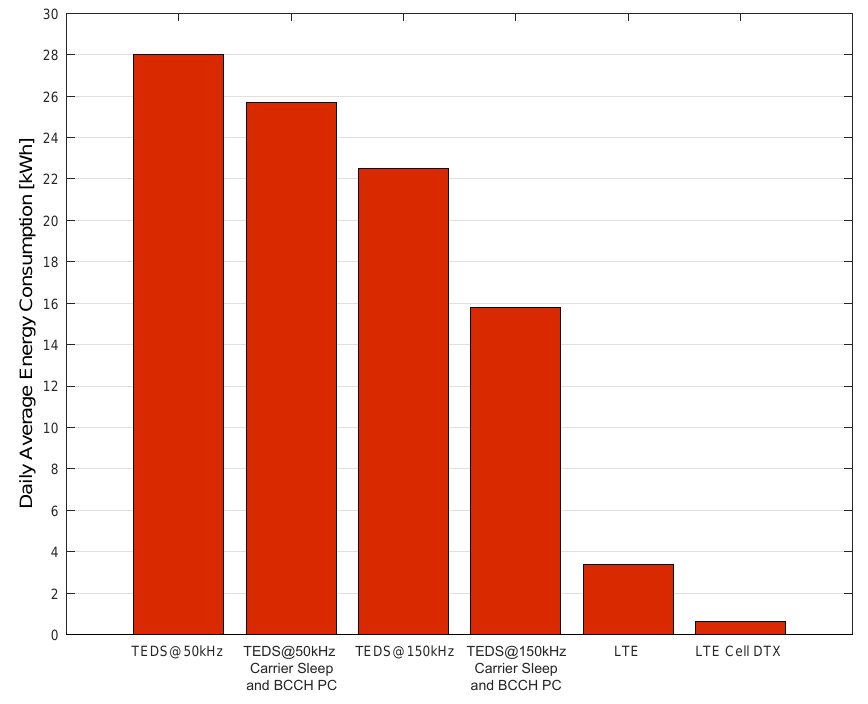
Figure 11. Comparison of daily average energy consumption of TETRA and LTE radio base